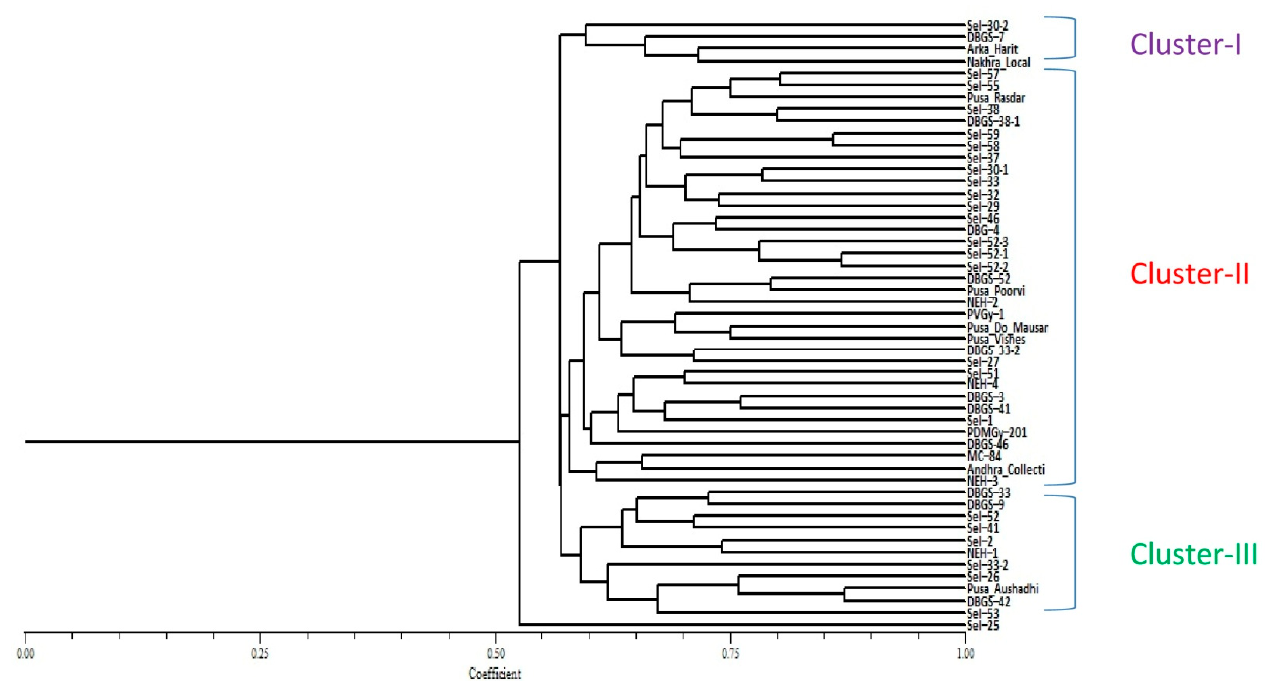
Figure 3. The unweighted pair group method of arithmetic mean (UPGMA) trees of 51 Momordica accessions, based on 30 SSR polymorphic markers.